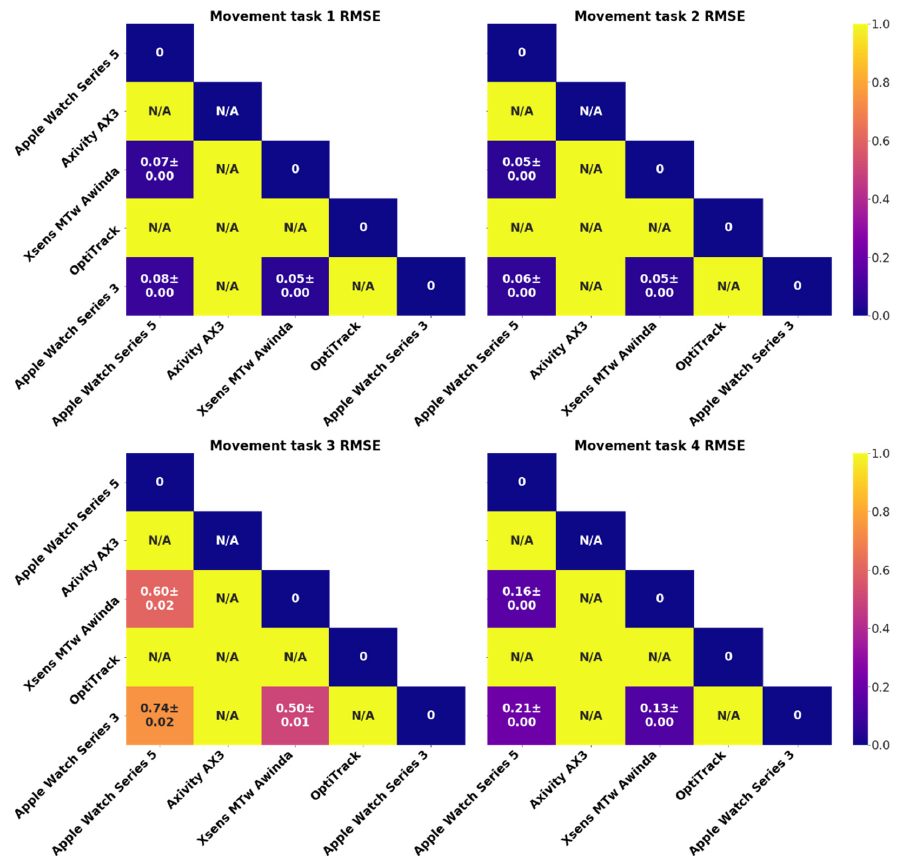
Figure A5. Depicts a breakdown of the angular velocity RMSE result in Figure 4d for each of the 4 movement tasks. Displayed RMSE in the figure are rounded. The unit is rad·s − 1